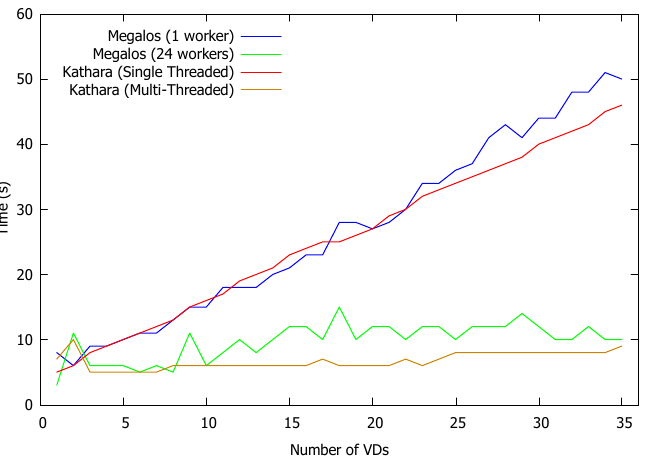
Figure 5. Startup times (green curve) of several network scenarios with a growing number of VDs hosted in 24 Kubernetes worker nodes. For comparison we also show startup times for the cases when all VDs are hosted in a single Kubernetes worker node (blue curve); when all VDs run within Kathará single-threaded (red curve); and when all VDs run within Kathará multi-threaded (orange